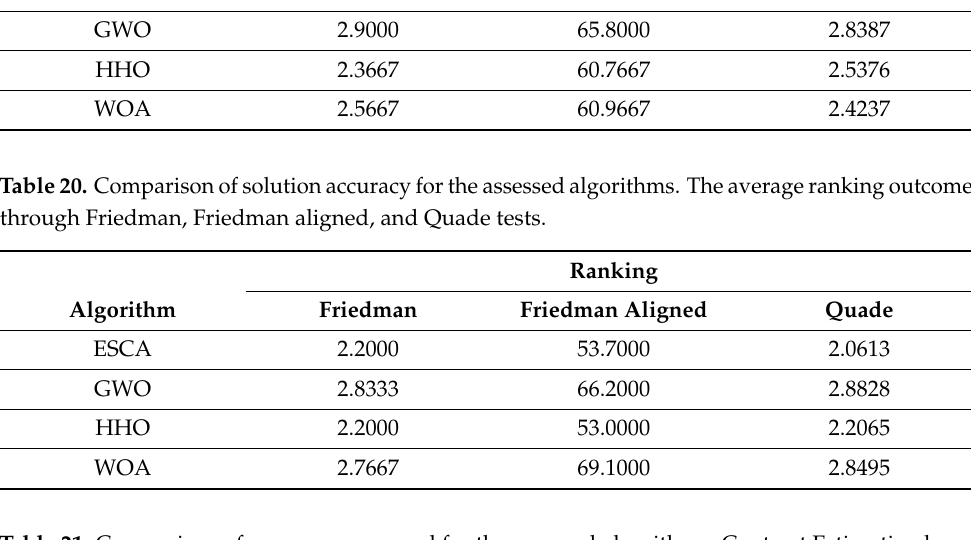
Table 21. Comparison of convergence speed for the assessed algorithms. Contrast Estimation based on